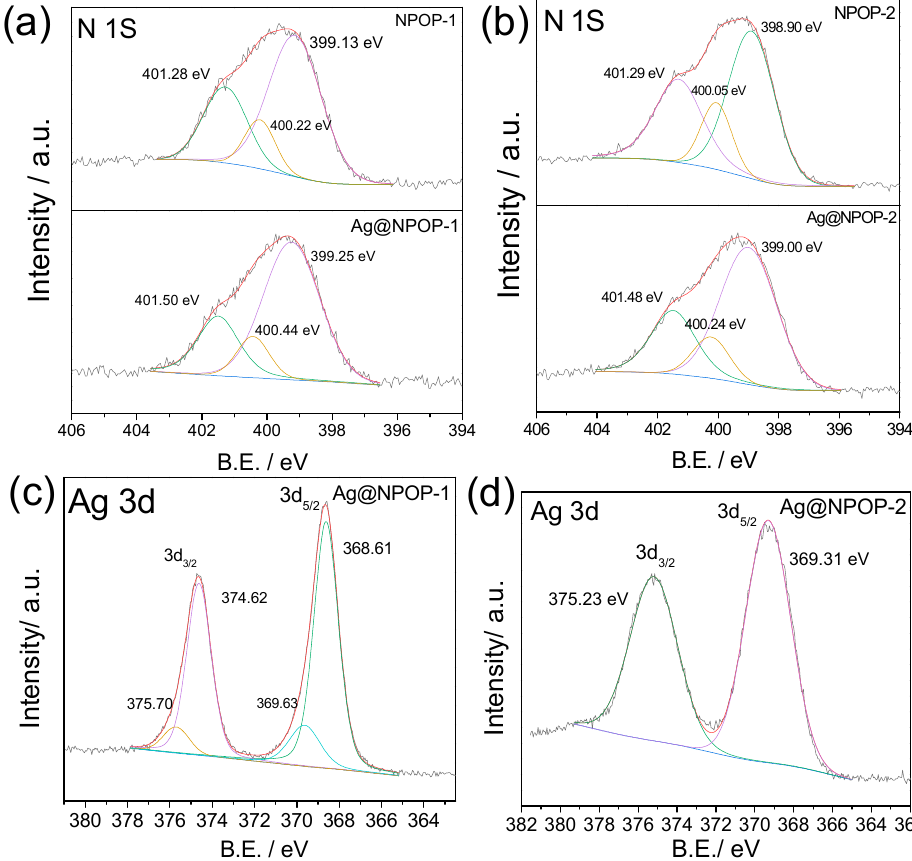
Figure 5. XPS and deconvoluted spectra of high-resolution N 1s for: ( a ) NPOP-1 and Ag@NPOP-1, and ( b ) NPOP-2 and Ag@NPOP-2. XPS and deconvoluted spectra of high-resolution Ag 3d for: ( c )